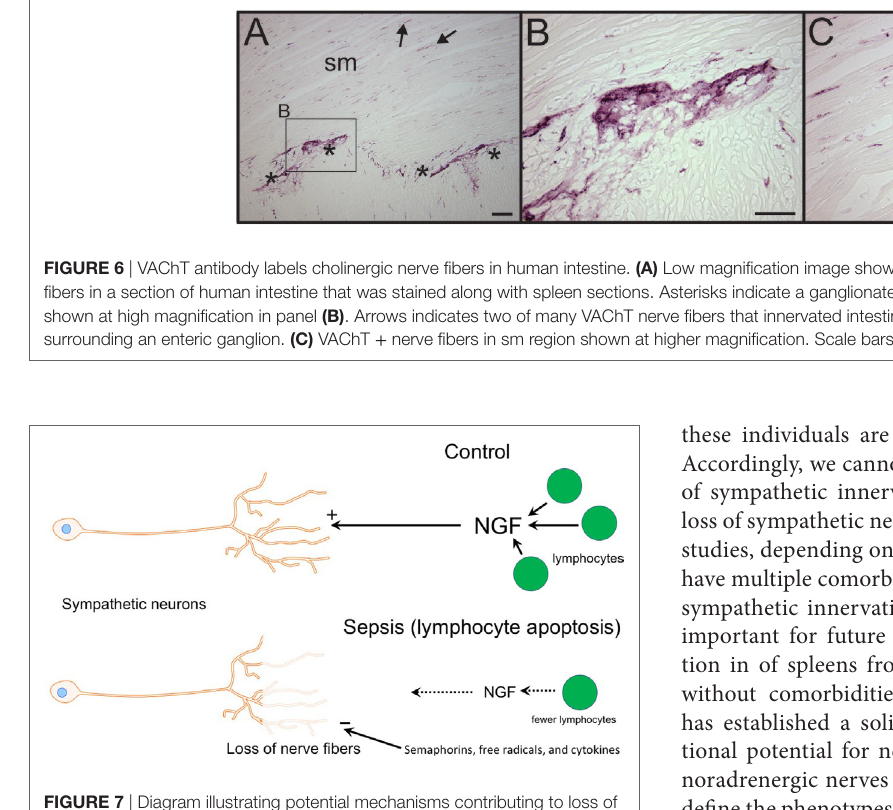
FigUre 7 | Diagram illustrating potential mechanisms contributing to loss of sympathetic nerves in end stage sepsis. Top panel shows normal condition (control) where sympathetic innervation is maintained by nerve growth factor (NGF), which is most likely supplied by T and B cells. The bottom panel depicts changes in sepsis that could contribution to the loss of sympathetic nerves. Loss of lymphocytes in the septic spleen would decrease the supply of NGF, which is needed to maintain sympathetic nerves. Semaphorins, which are nerve repellants, could be generated in the septic spleen and cause retraction of sympathetic nerves through their interaction with the neuropilin-2/plexin A2 receptor complex located on tyrosine hydroxylase (TH) + nerve fibers. Toxic free radicals and inflammatory cytokines, generated locally during sepsis, might contribute to degeneration of TH + nerve